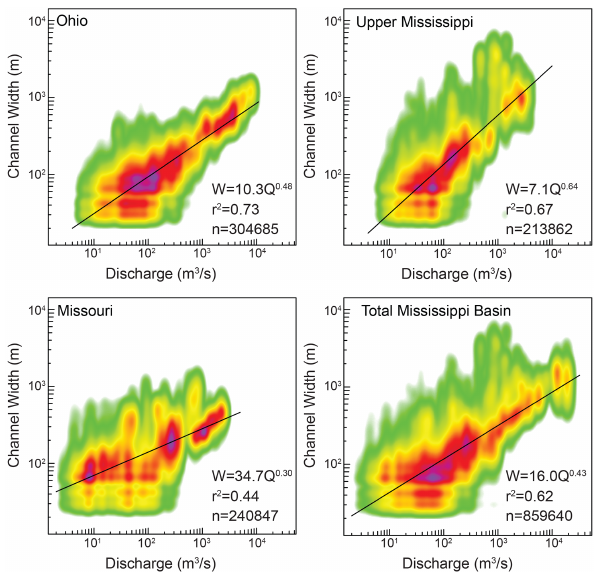
Figure 10. Density plots of width versus discharge for the Ohio, Upper Mississippi, Missouri, and entire Mississippi Basin. Linear fits represent downstream hydraulic geometry relationships analo- gous to Eq. (1a).